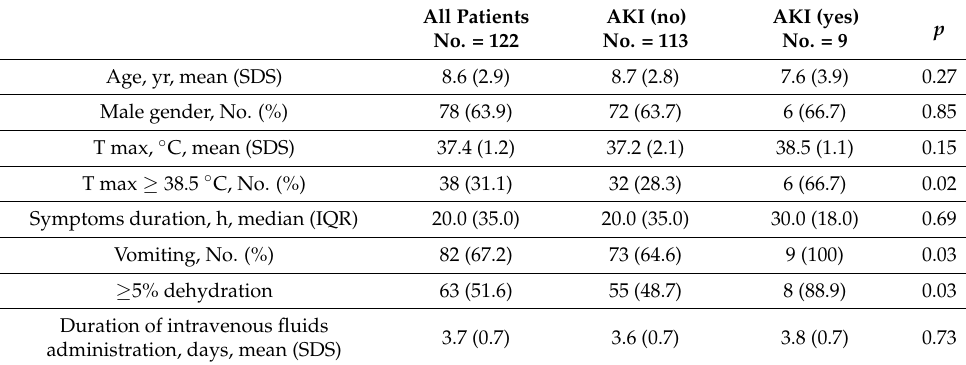
Table 1. Clinical and laboratory characteristics of children hospitalized for acute appendicitis with and without